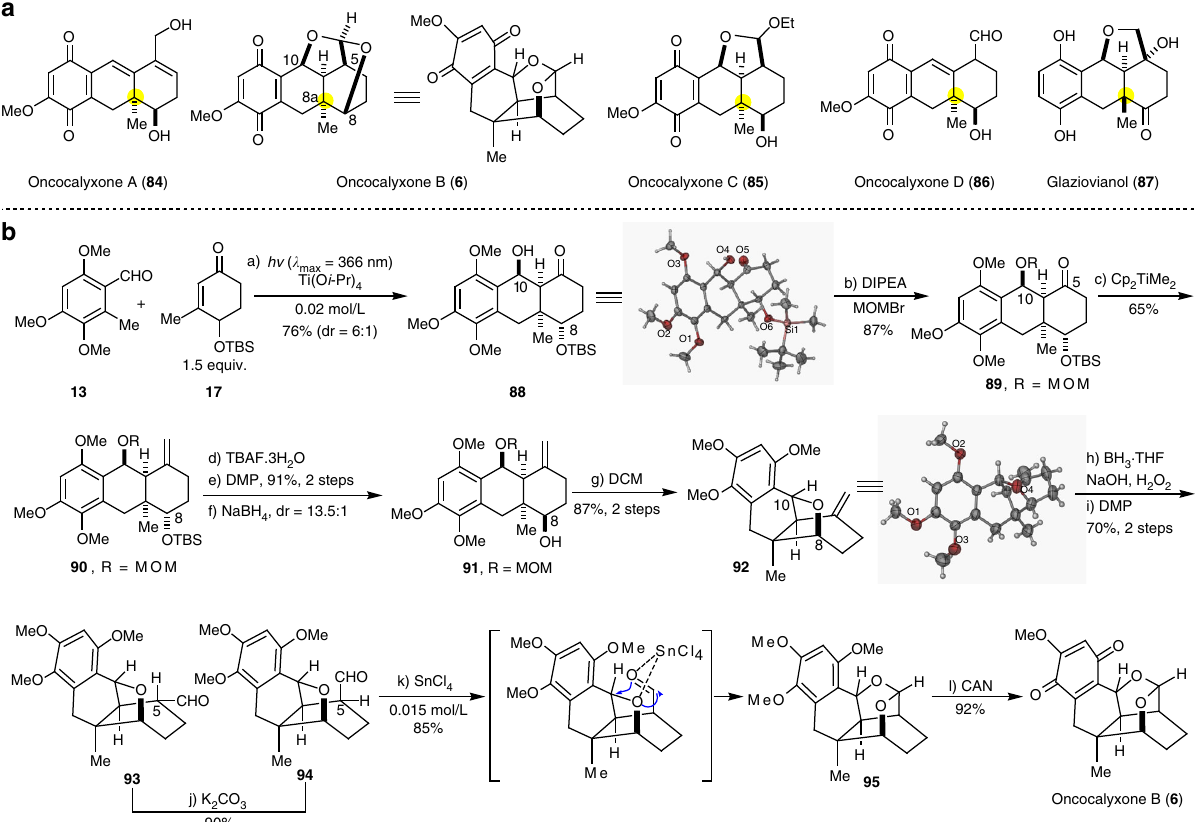
Fig. 3 Synthetic application. a Structurally related natural products contain hydroanthracenol and related polycyclic rings and all-carbon quaternary centers. b Total synthesis of oncocalyxone B. (a) hv ( λ max = 366 nm), Ti(O i -Pr) 4 , toluene, dr = 6:1, 76%; (b) DIPEA, MOMBr, DCE, 80 °C, 87%; (c) Cp 2 TiMe 2 , toluene, 80 °C, 65%; (d) TBAF . 3H 2 O, DMF, 90 °C; (e) DMP, DCM, RT, 91% over 2 steps; (f) NaBH 4 , MeOH, 0 °C, dr = 13.5:1; (g) DCM, RT, 87% over 2 steps; (h) BH 3 .THF, 3N NaOH, H 2 O 2 , 0 °C; (i) DMP, DCM, RT, 70% over 2 steps; (j) K 2 CO 3 , EtOH (degassed), RT, 90%; (k) SnCl 4 , DCM (0.015 M), − 78 °C to 0 °C, 85%; (l) CAN, CH 3 CN/H 2 O (2:1), 0 °C, 92%. DIPEA: diisopropylethylamine; MOMBr: bromomethyl methyl ether; DMP: Dess –